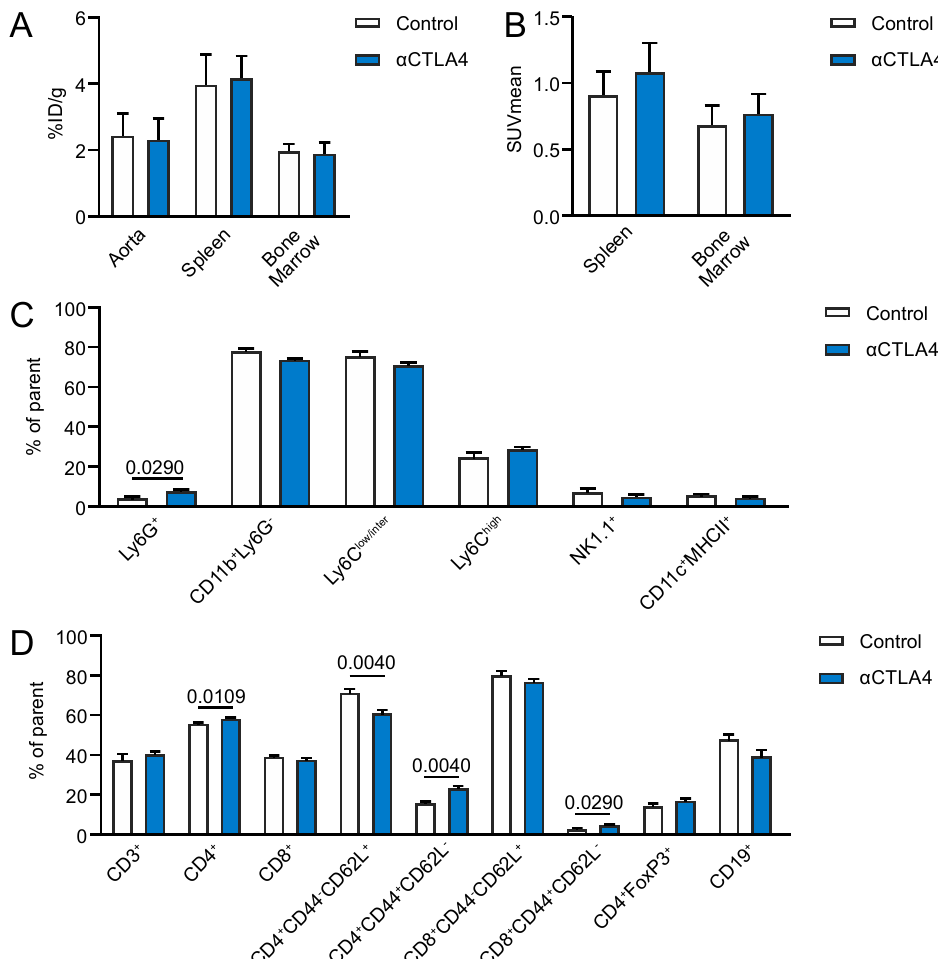
Figure 1. Antibody-mediated inhibition of CTLA4 induces an activated T cell profile in hyperlipidemic mice and does not a ff ect monocyte / macrophage-driven inflammation. ( A ) Ex vivo gamma counting of the aorta, spleen, and bone marrow ( n = 8). ( B ) Positron Emission Tomography—Computed Tomography revealed no di ff erences in the 18 F-fluorodeoxyglucose uptake in the spleen and bone marrow of α CTLA4-treated mice ( n = 8). ( C , D ) Flow cytometry of cells from the spleen of control and α CTLA4-treated mice ( n = 5–9).